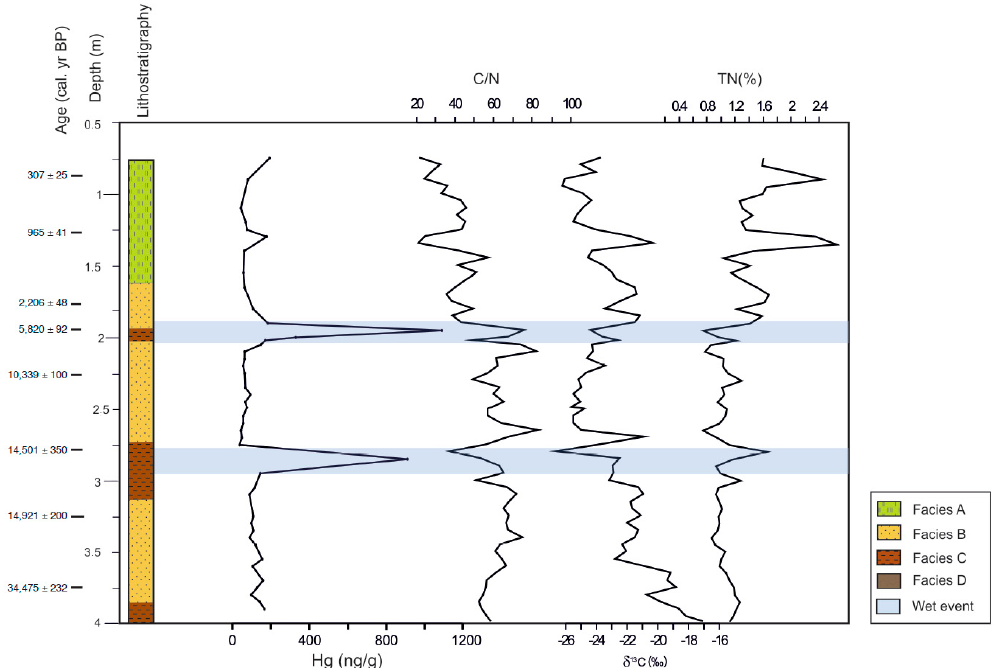
Figure 3. Depth profiles of the main paleoenvironmental proxies and Hg concentration analyzed in the ARO 08 02 core versus depth. Lithology and radiocarbon age samples are indicated in the column. Geochemical proxies: TN (C/N ratios and δ 13 C, are indicative of the origin of organic matter; Facies C [31] is wet event indicator. Periods of high rainfall events and drought conditions are